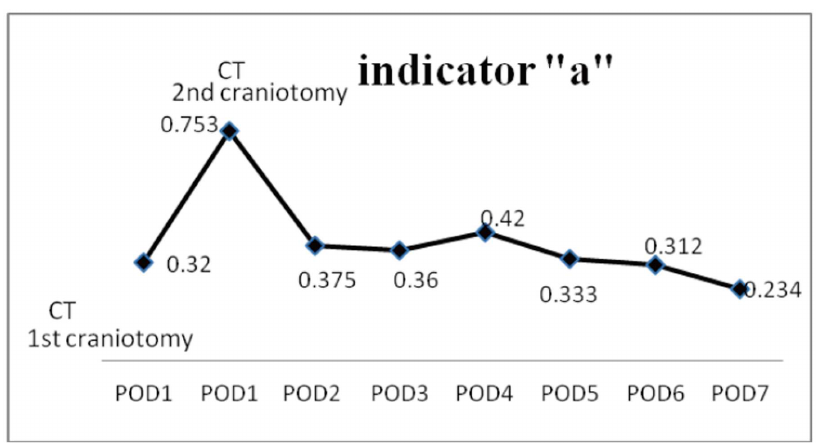
Fig 8. The change of mean of indicator “ a ” in parabolic P-V curve in case 3. The indicator “ a ” elevated rapidly from 0.32 to 0.753 during POD 1. After a second craniotomy, the indicator “ a ” declinedto 0.375. The mean of indicator “ a ” from POD 2 to POD 7 fluctuated between 0.234 and 0.42 and no more rapid elevation of “ a ” was noted after the second